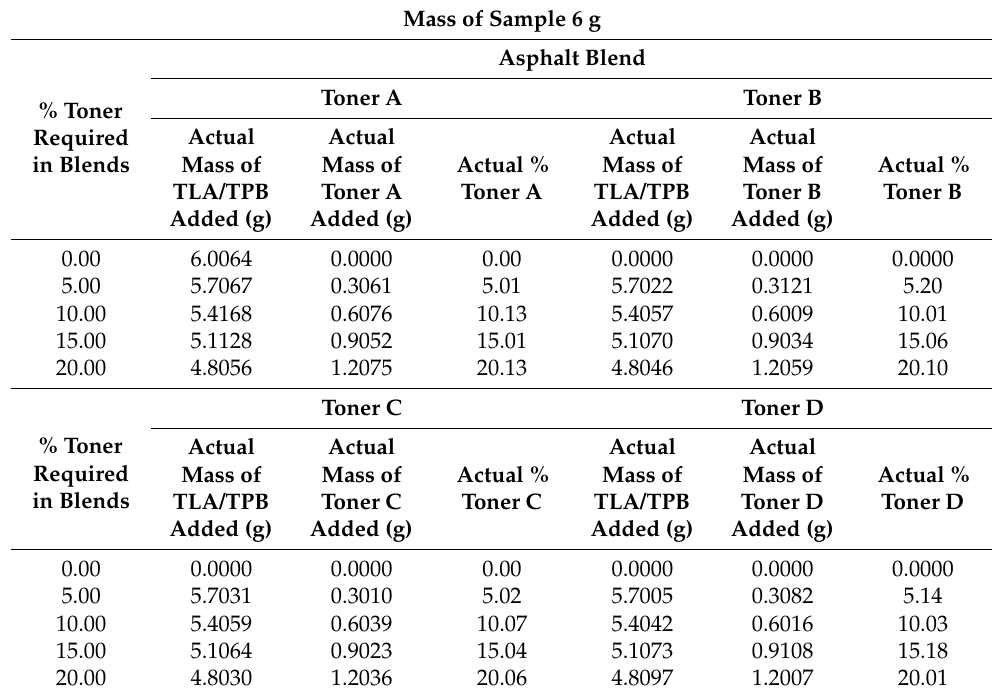
Figure 10. The following depicts the process, which was adopted from a previous study, that was undertaken to obtain the waste toners that were added to the TLA/TPB paving binder. ( a ) Image of a sample printer cartridge; ( b ) Deconstruction of printer cartridge to access waste toner powder; ( c ) Example of the waste toner product [36]. Table 2. Concentration of sample blends utilized in this